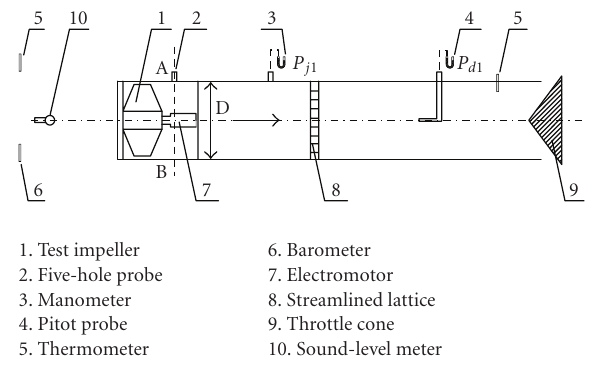
Figure 9: Experimental setup. Table 2: Comparison of aerodynamic performance between two impellers at design